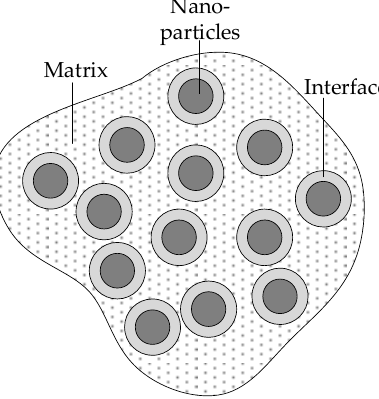
Figure 1. Schematic diagram of the nanoparticle interface.